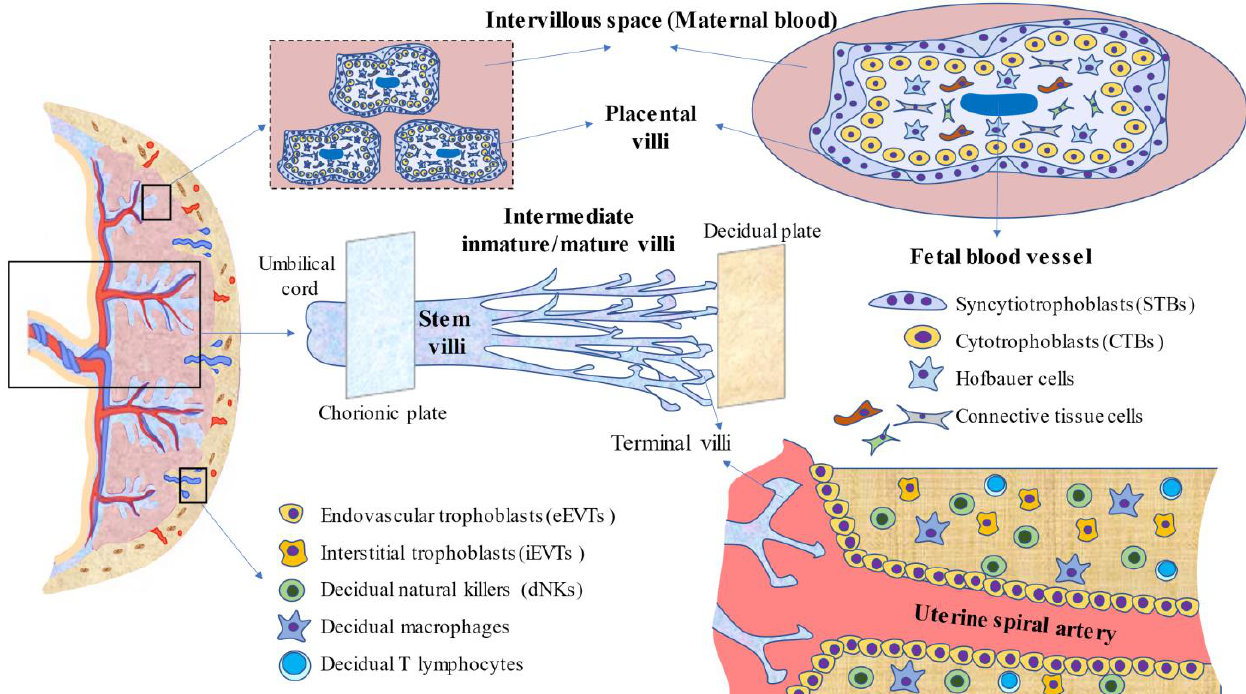
Figure 1. An integrative picture of the components of the placenta. Herein, the main cell types and structures formed are summarized. At the top, placental villi and their cells, as well as the location of the maternal and fetal blood, in the intervillous space and inside the villi, respectively, are represented. In the center of the image, the villous tree, as well as the different types of villi, are represented. The chorionic plate, or fetal surface, is covered by the amnion, where the umbilical cord is attached. The decidual basal plate or maternal surface is in contact with the endometrium. As represented at the bottom, profound remodeling of the uterine spiral arteries is mainly due to the coordinated efforts of a set of cells, mainly extravillous trophoblasts (EVTs) and immune cells, prominently represented by decidual natural killers (dNKs). Having complete knowledge of the placenta in non-pathologic pregnancies is crucial for the study of different pregnancy complications, as the placenta is responsible for a wide variety of functions, as is subsequently